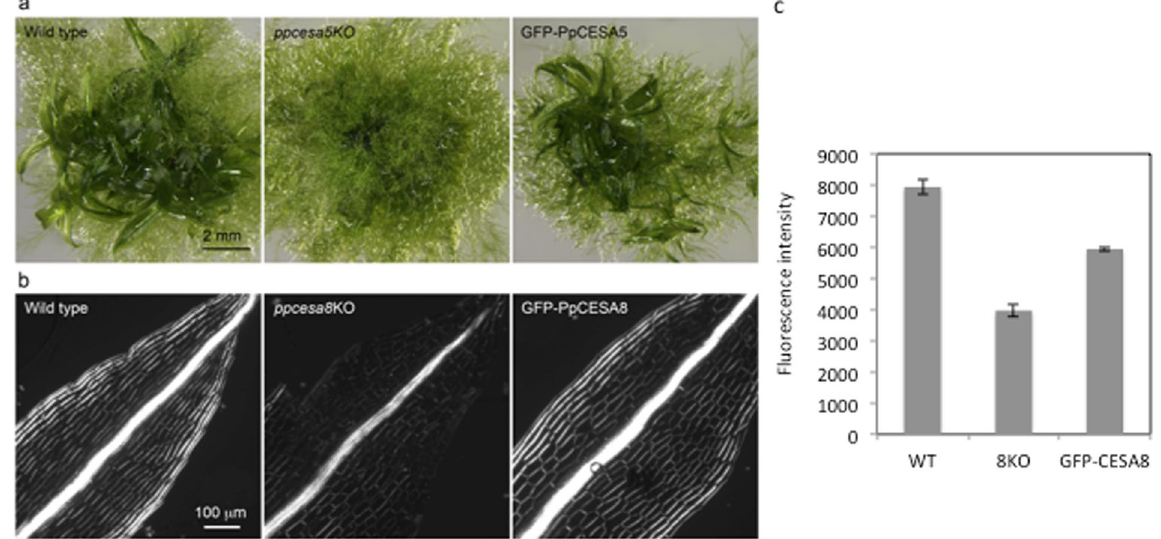
Figure 1. Expression of mEGFP-PpCESAs rescue the cognate mutant phenotypes. ( a ) Transformation of the gametophore defective ppcesa5KO-2 line with Ubi::GFP-PpCESA5 restores wild type gametophore development. ( b ) Transformation of the ppcesa8KO-5B line, which is characterized by weak midrib birefringence due to reduced secondary cell wall deposition, was partially restored to the wild type phenotype by transformation with Act1::GFP-PpCESA8 . ( c ) Quantitative analysis of fluorescence intensity in midribs stained with S4B confirmed partial restoration of the wild type phenotype by expression of Act1::GFP-PpCESA8 the ppcesa8KO-5B line.